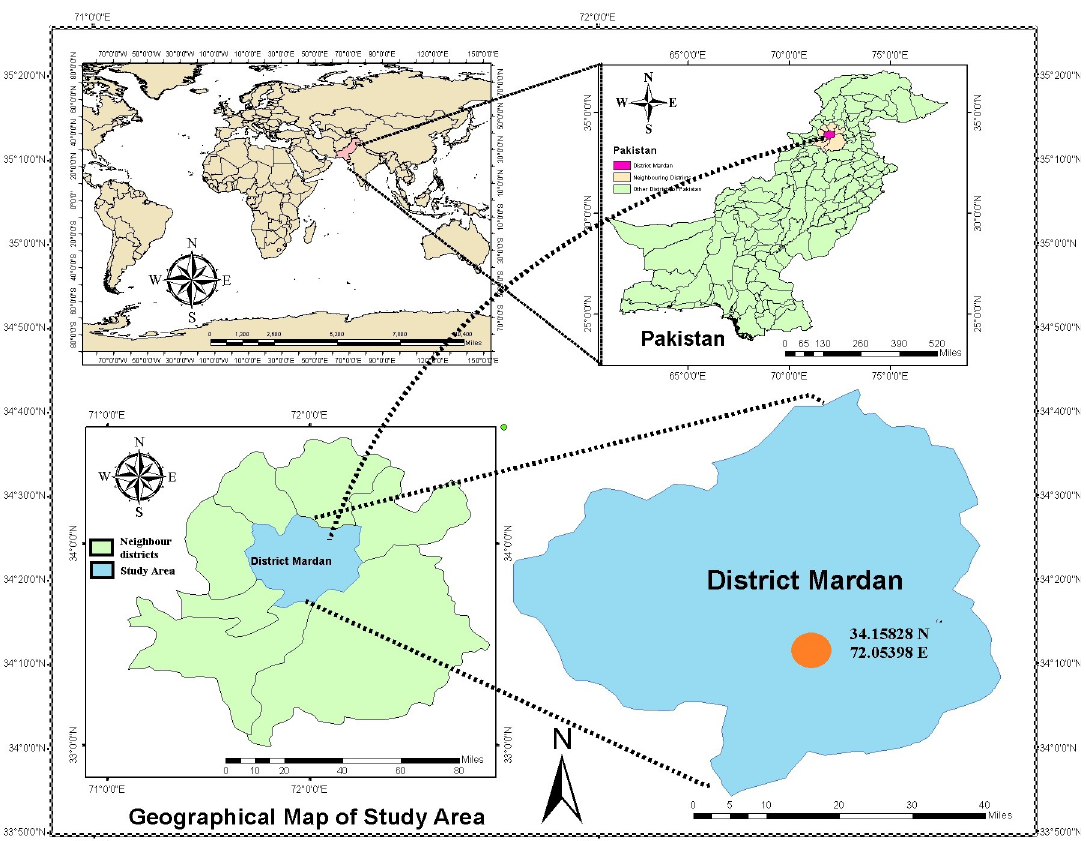
Fig 1. Map of the study